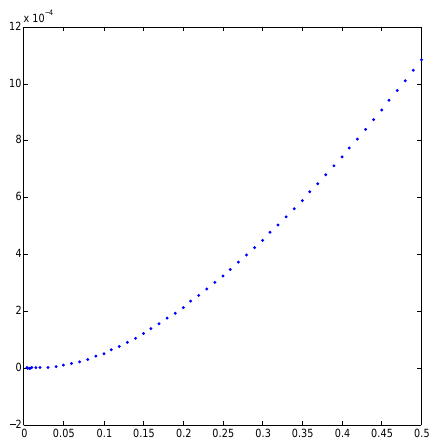
Fig. 1: The term R A ( d c ) in a function of d c .